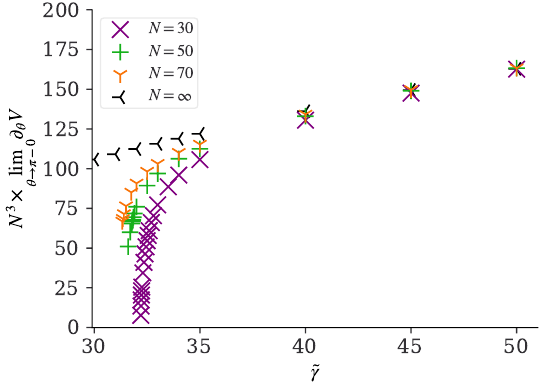
Figure 4. Numerical results in the partial phase for ∂V ∝ h tr( F µν ˜ F µν ) i times N 3 in the limit ∂θ θ → π − 0 as a function of “temperature” ˜ γ , for N = 30 (purple crosses), 50 (green plus signs), 70 (orange 3-point star), and ∞ (black 3-point star). The error bars are invisibly small on the scale of the plot. In all cases, we see clearly that h tr( F µν ˜ F µν ) i 6 = 0 and hence CP symmetry is spontaneously broken in the partial phase. We also see that the finite- N results smoothly approach the N = ∞ result as ˜ γ